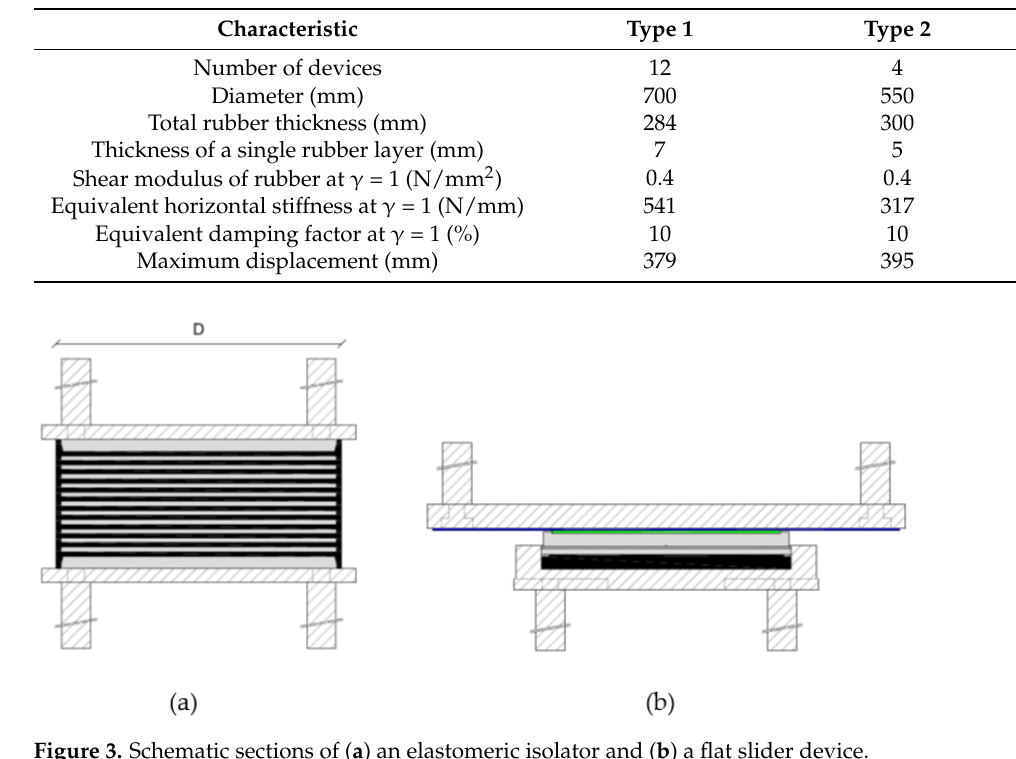
Table 1. Nominal characteristics of the two types of